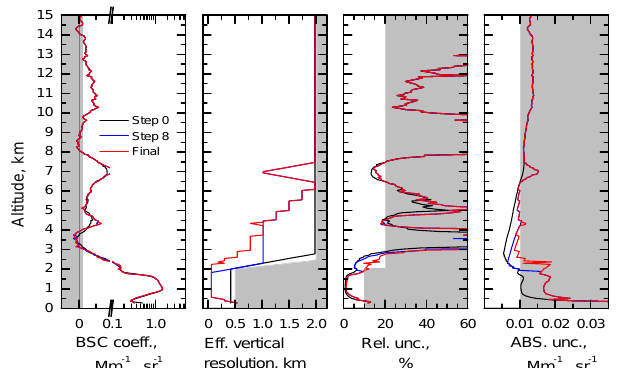
Figure 4. Illustration of the automated smoothing procedure. The example Raman backscatter profile at 532nm was measured on 28 May between 20:09 and 20:24UT in Leipzig with the MARTHA lidar. Panels from left to right show the particle backscatter coef- ficient, the effective vertical resolution, the relative statistical un- certainty, and the absolute statistical uncertainty. Gray areas show constraints of the smoothing procedure and of the uncertainties, the black, blue, and red curves show the initial maximum smoothing, the status after 8 iteration steps, and the final result (after 16 itera- tion steps), respectively.